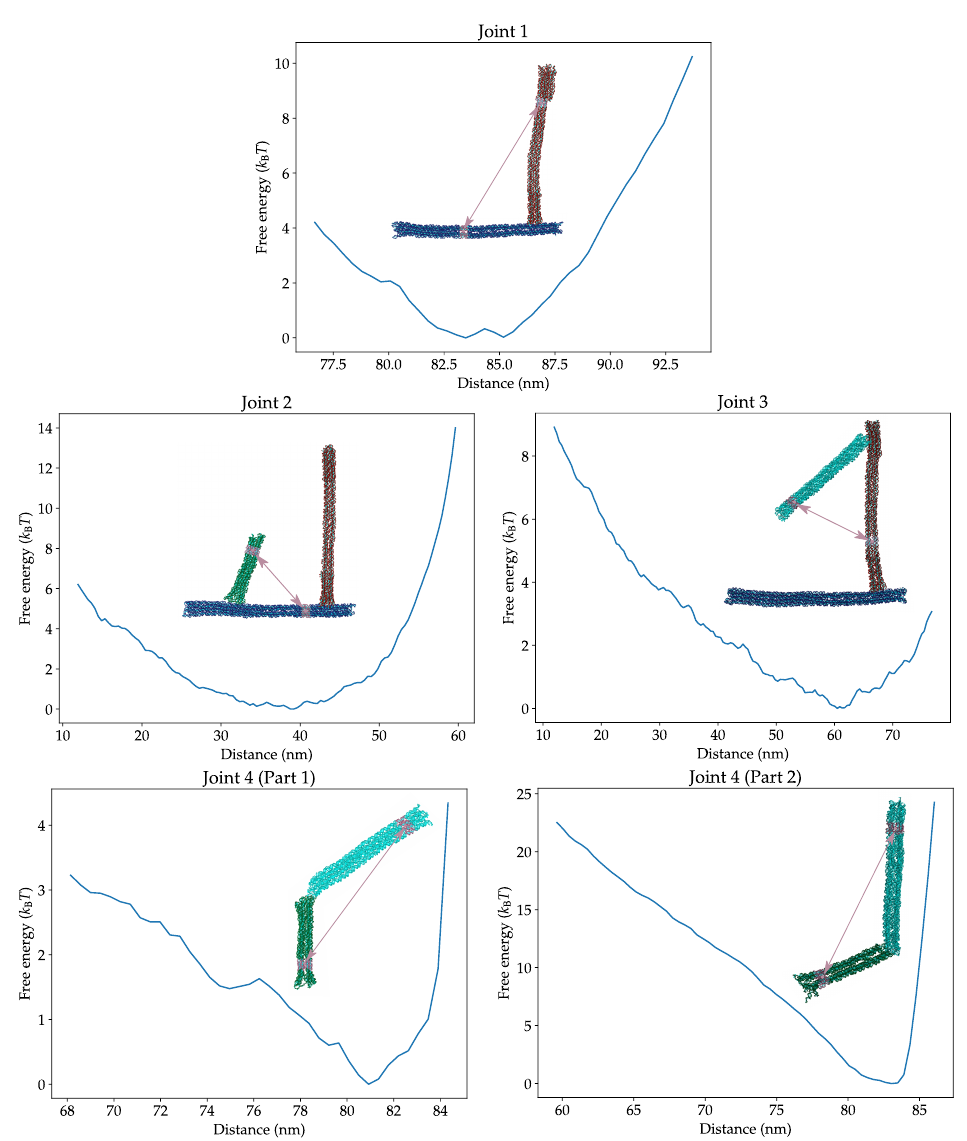
Figure 3. The free-energy landscapes associated with each individual joint. The configurations illustrate the subsystems used to compute these landscapes and the definitions of the distance order parameters. The values of these order parameters in the depicted configurations are 86 nm, 45 nm, 51 nm, 78 nm and 70 nm, respectively. The landscape associated with joint 4 has been computed in two parts corresponding to whether the joint is pointing outwards (1) or inwards (2). Only when joint 4 is straight do these sub-landscapes sample equivalent